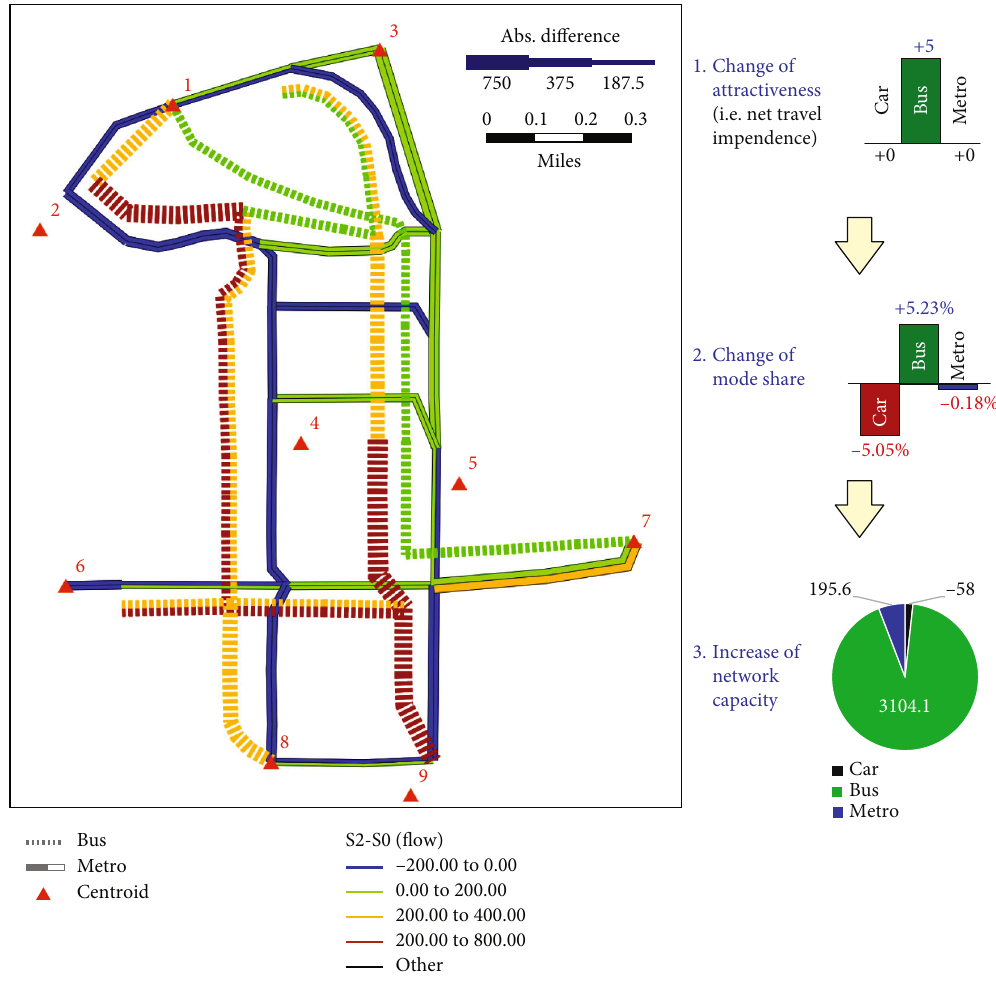
Figure 16: Comparison of maximum fl ow patterns before and after increasing bus